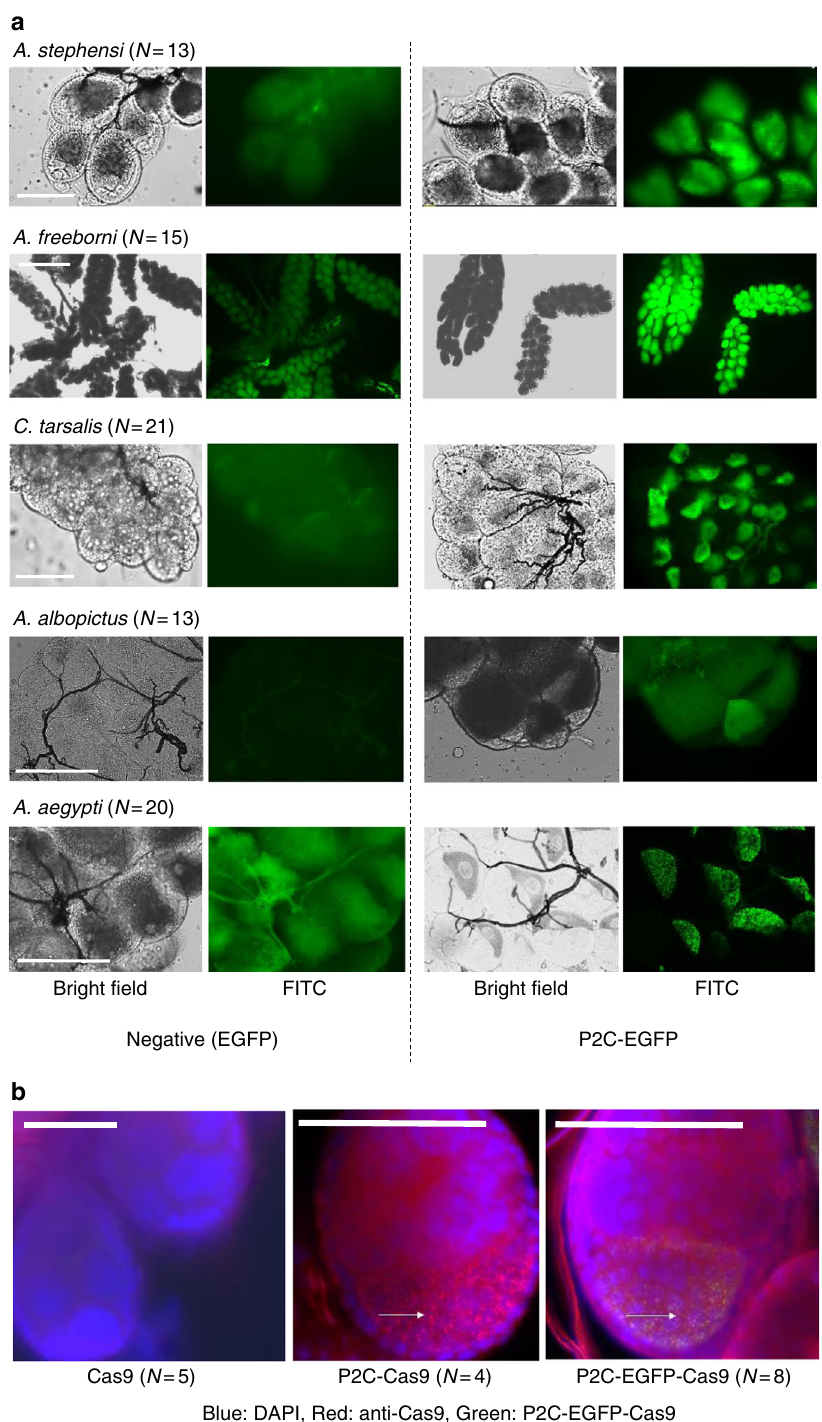
Fig. 2 P2C-mediated protein translocation in several mosquito species. a P2C-EGFP, expressed in E. coli using the plasmid pET28a (See details